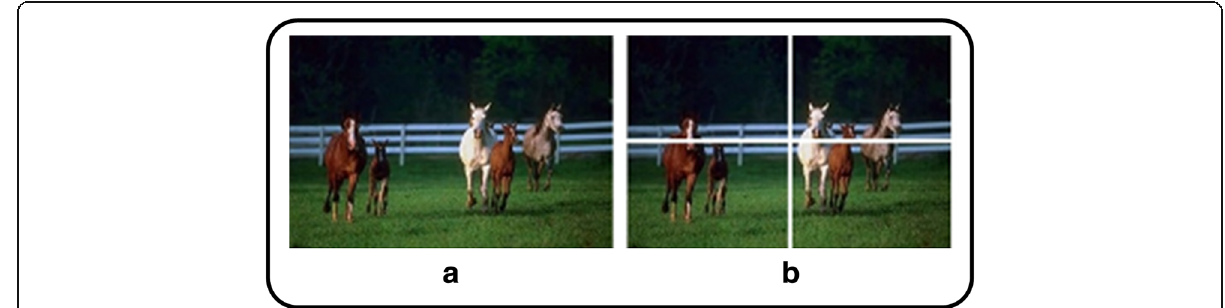
Fig. 5 Image a is chosen from the semantic class “ Horses ” of the Corel-1K image benchmark, and image b is presenting the division of the image into four rectangular areas for computation of histogram from each rectangular area [40]